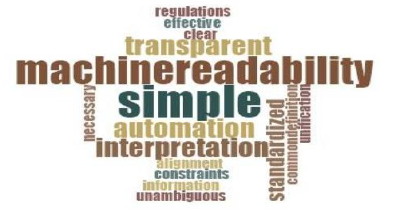
Figure 6. EUnet4DBP Principles for Technologies.